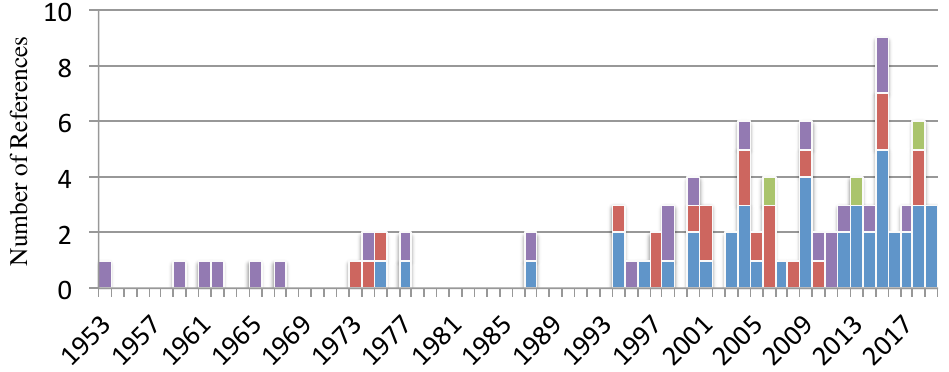
Figure 8. Illustration of the problem